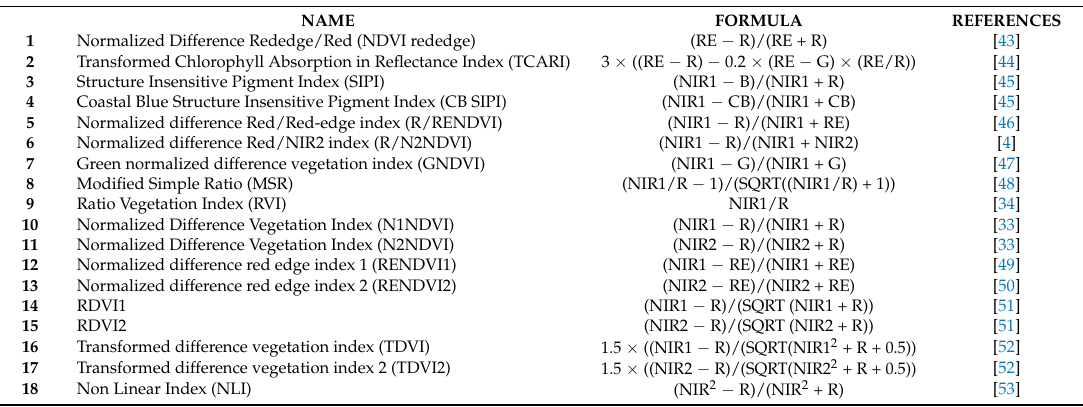
Table 1. Vegetation indices used in this